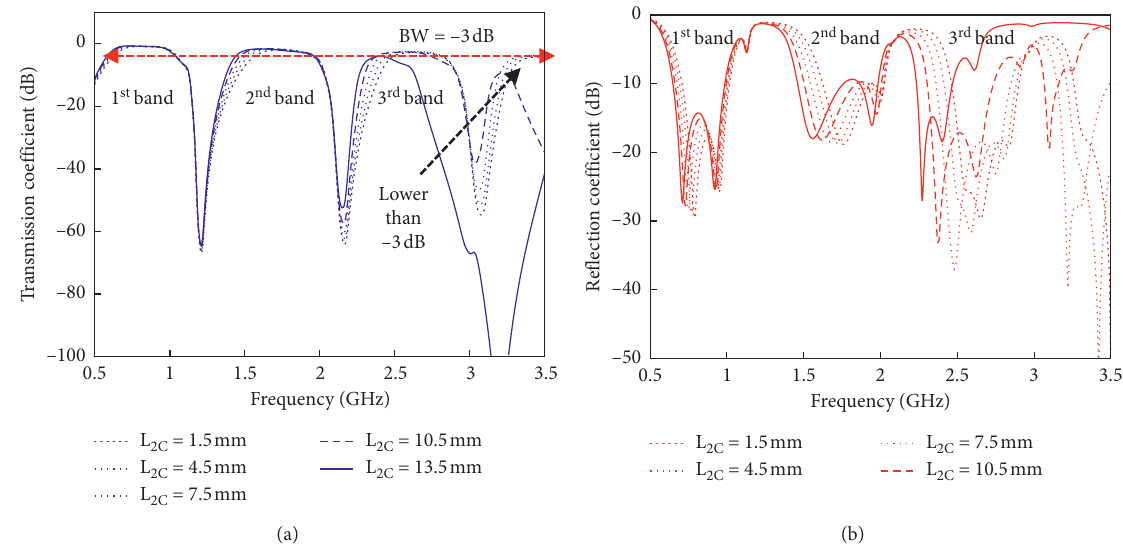
Figure 8: (a) Transmission coefficients ( S 21 ) of the proposed MW-BPF using a folded QC-SSIR with varied L 2 C values. (b) The reflection coefficients ( S 11 ) of the proposed MW-BPF using a FQC-SSIR with varied L 2 C values.